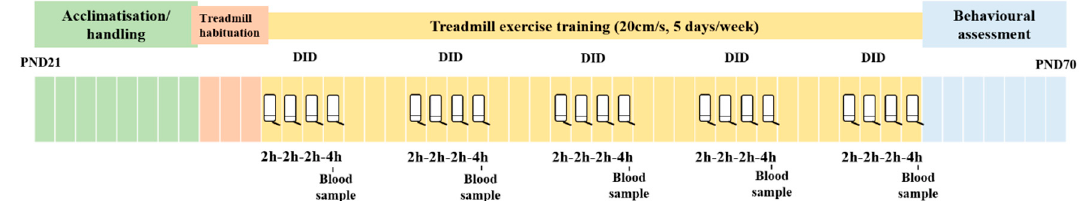
Figure 1. Schematic representation of the experimental timeline. C57BL / 6J mice were exposed to a 5-week Drinking the Dark (DID) procedure. Every 15 days after a 4 h session, a blood sample was obtained from the lateral tail vein to analyze BECs. Concurrently, animals from the EX and EX + EtOH groups were submitted to treadmill exercise training (20 cm / s) for 20 min, 5 days / week. Finally, from pnd 64 to 70, all animals were tested on different behavioral tasks.